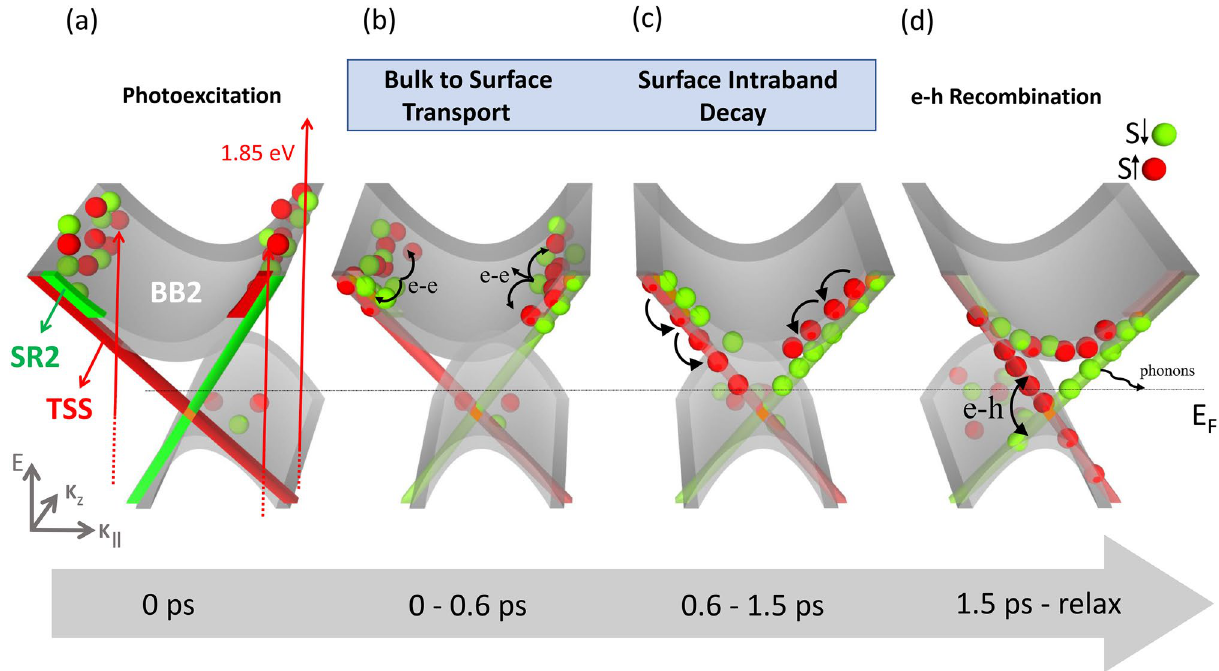
Figure 4. The schematic representation of the electronic distribution after excitation of Bi 2 Te 3 by a linearly polarized pulse. Each panel shows the dominant process. ( a ) First, upon the photoexcitation, the 1.85 eV pump promotes electrons above the Fermi level, hot electrons fill mainly the unoccupied BBs. ( b ) BB electrons scatter and move to the surface. ( c ) Intraband scattering process in TSSs and SRs. ( d ) Bottom of B2 and TSS relax by electron-hole recombination and energy transfer to